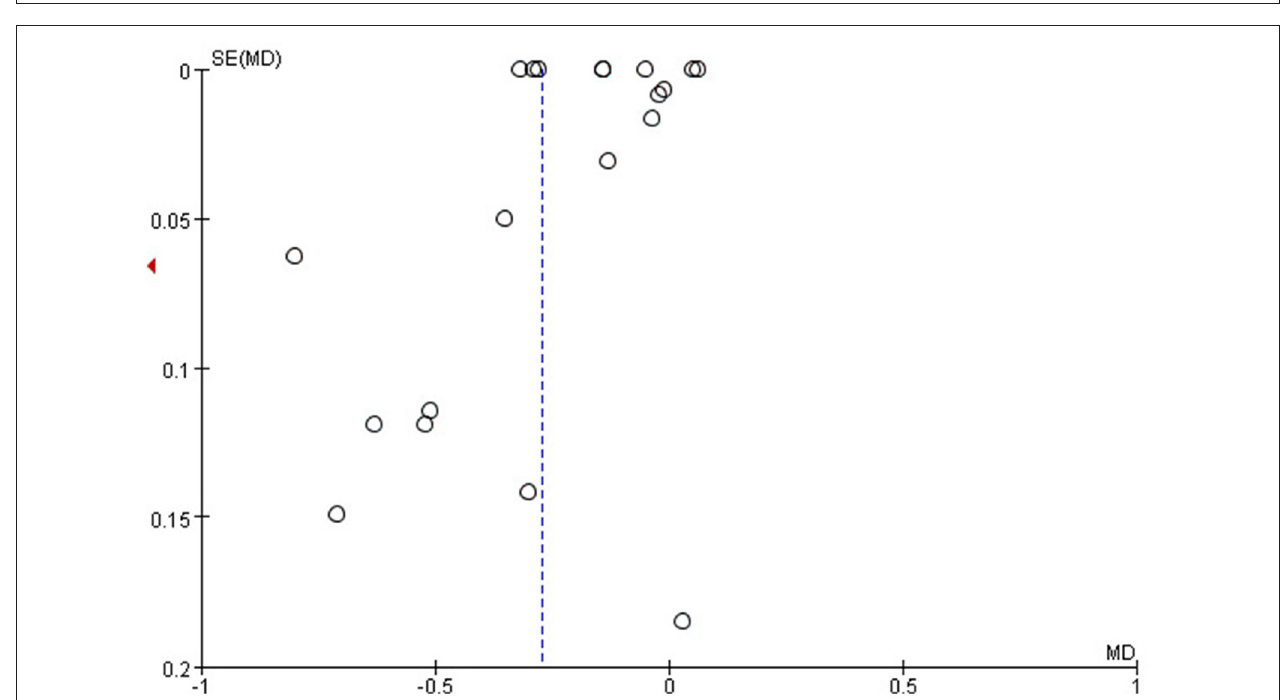
FIGURE 6 | The plot of the spherical equivalent refraction during COVID-19 pandemic and before it.